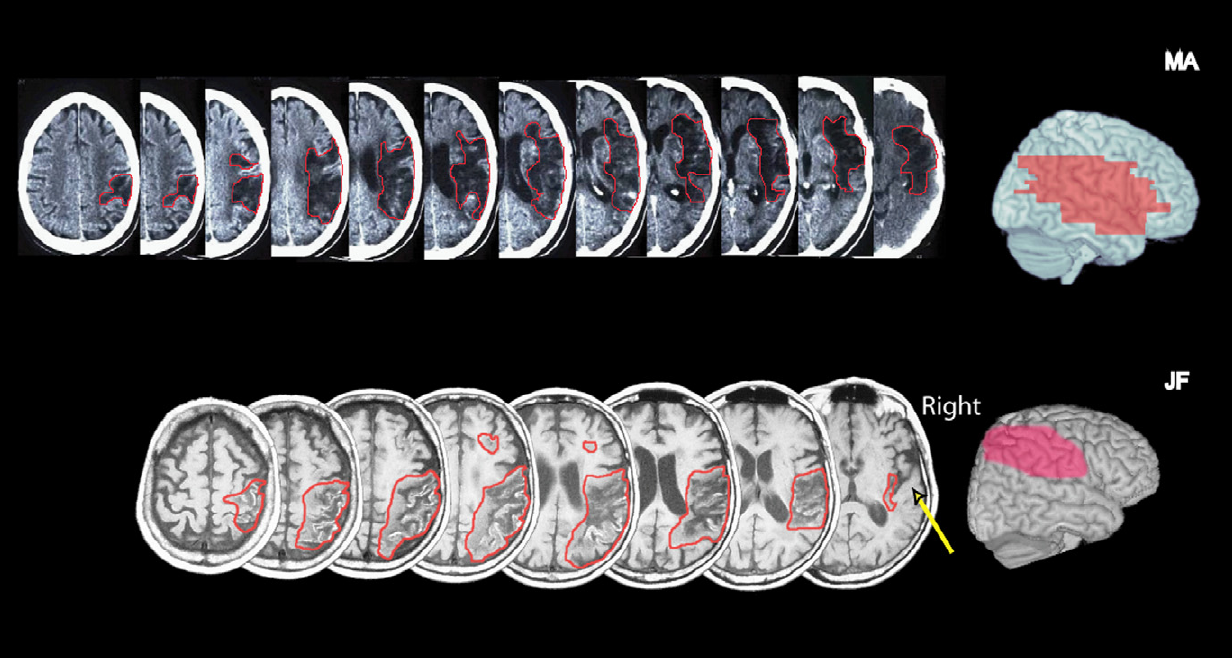
Figure 1. Left: Representative CT slices of patient MA (top row) and T1 MRI slices of patient JF (bottom row). The right side of the brain is on the right. The affected area is marked by a red line. Right: A lateral view of the cortical lesion projected onto a normal brain. For this reconstruction, the lesions were drawn -weighted single subject template MRI scan from the Montreal Neurological Institute manually using MRIcrosoftware (http://www.mricro.com) on slices of a T 1 (www.bic.mni.mcgill.ca/cgi/icbm_view), distributed with MRIcro. In JF, the right parietal and posterior frontal cortex is affected, but the superior temporal plane is spared (arrow pointing to transverse temporal gyri). A small white matter extension is seen in the right frontal lobe. In MA a more extensive right MCA lesion affected the inferior parietal lobe, superior and middle temporal gyri, and inferior frontal regions, as well subcortical